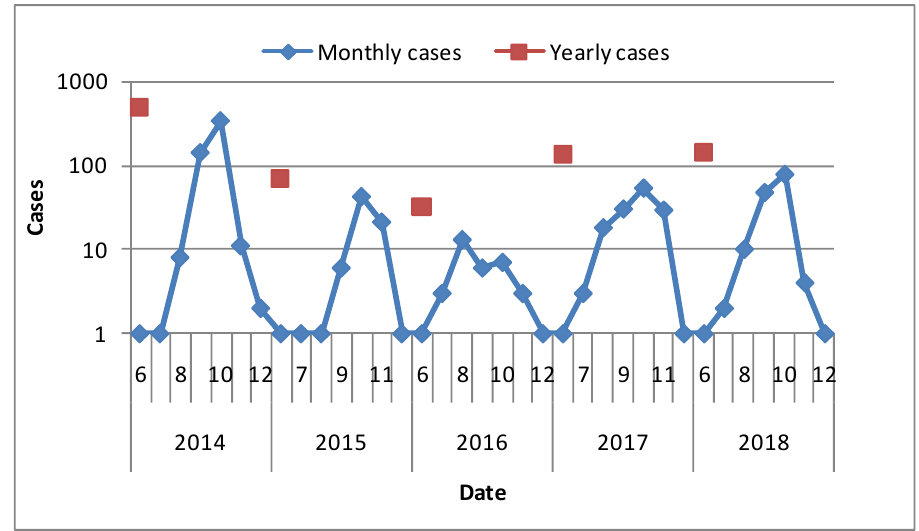
Figure 1. Time-series mapping of domestic imported dengue cases (domestic imported dengue cases were among June to December during